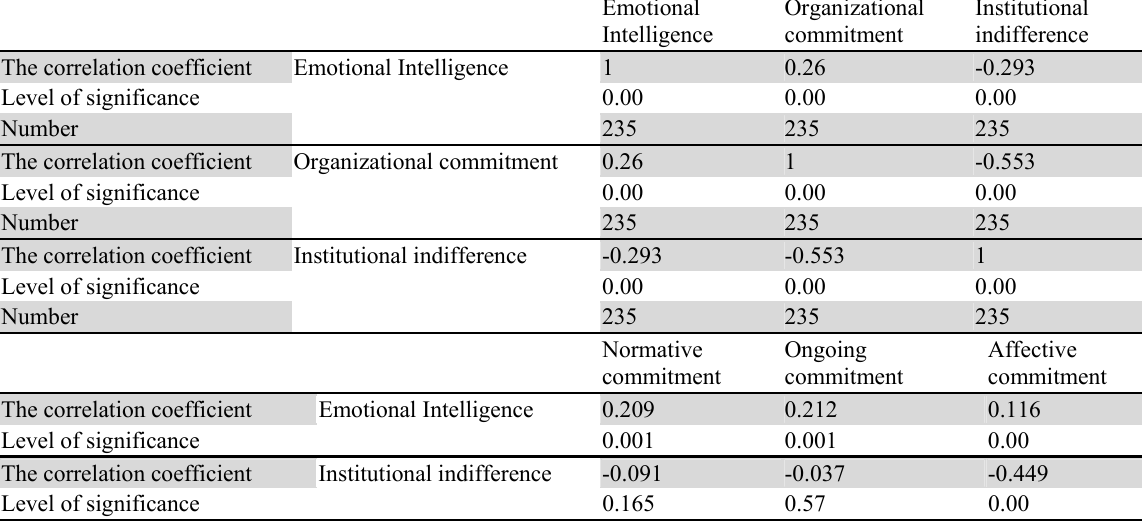
Spearman correlation test results for